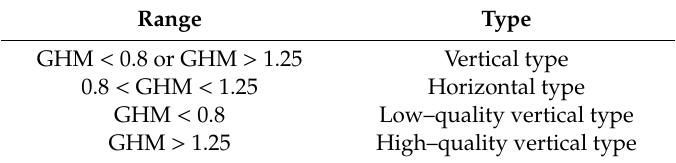
Table 1. The intra-industry trade structure (GHM) index corresponds to the type of intra-industry